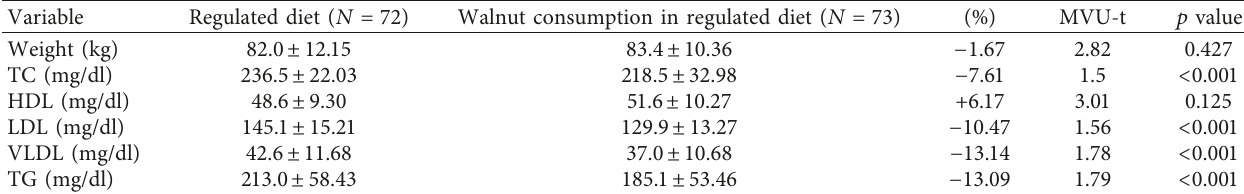
Table 3: Comparison of the groups at 3rd